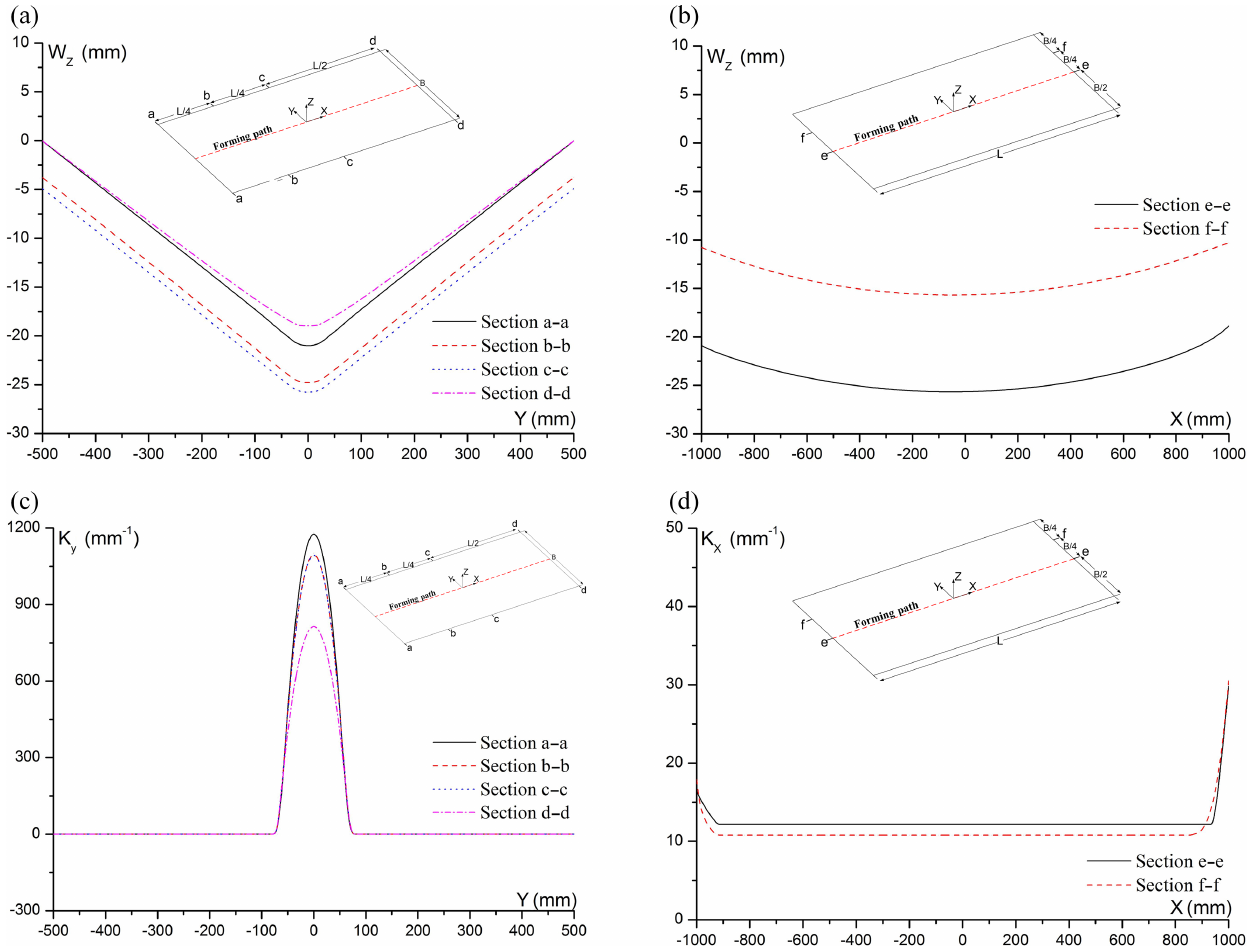
Figure 4. Results of deformation and curvature ( δ = 0.2h). (a) Deformation in y direction. (b) Deformation in x direction. (c) Curvature in x direction. (d) Curvature in y